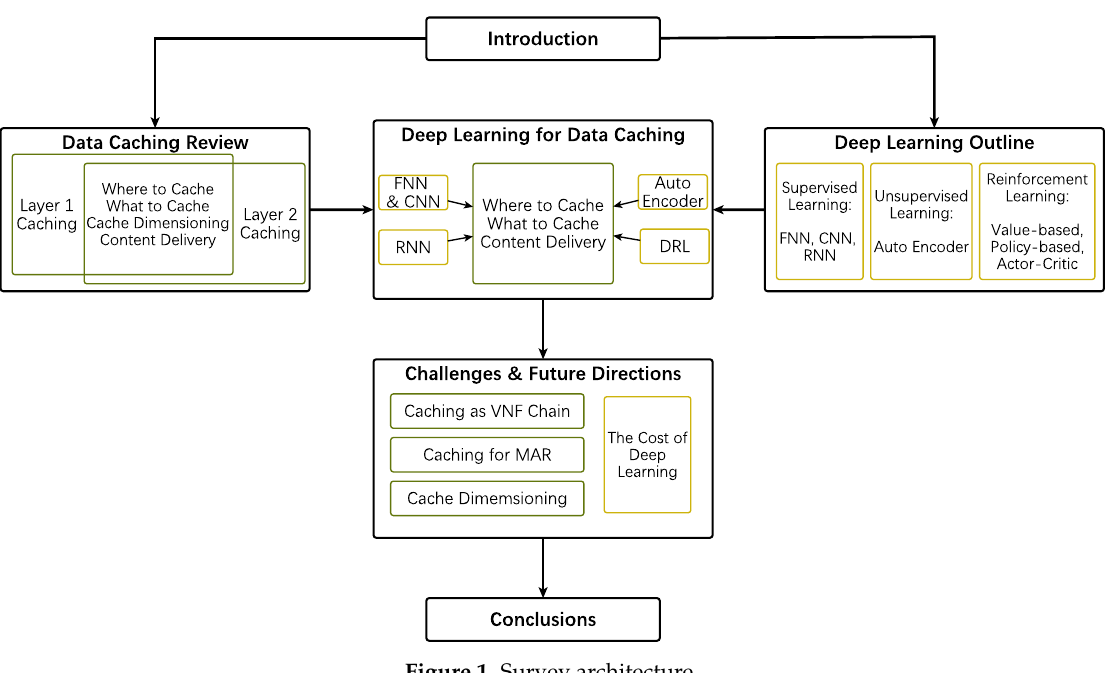
Figure 1. Survey